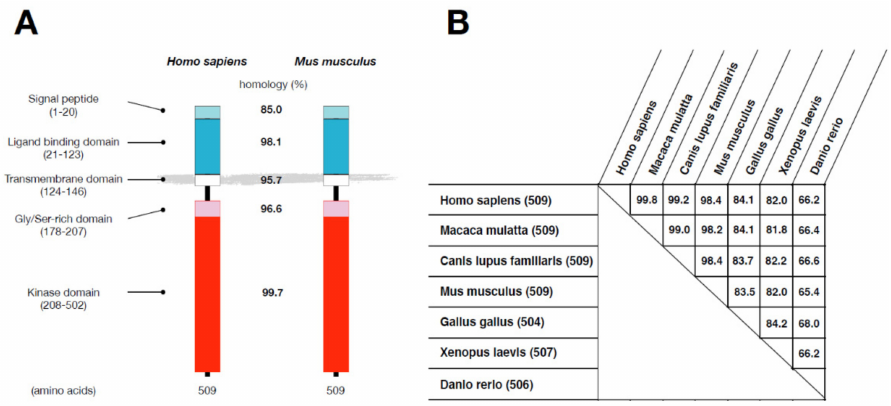
Figure 2. ALK2/ACVR1 in different species: ( A ) Human and mouse ALK2/ACVR1. The amino acid-based homology of each domain was calculated by Genetyx-Mac version 20 (Genetyx Co., Tokyo, Japan). ( B ) Homology of ALK2/ACVR1 among animal species. UniProt ID of animal species (Homo sapiens: Q04771, Macaca mulatta: F7A9J8, Canis lupus familiaris: A0A5F4C195, Mus musculus: P371728, Gallus gallus Q90ZK6, Xenopus laevis O42475, Danio rerio: Q9DGI6). Complete amino acid sequences of ALK2/ACVR1 were compared using Genetyx-Mac version